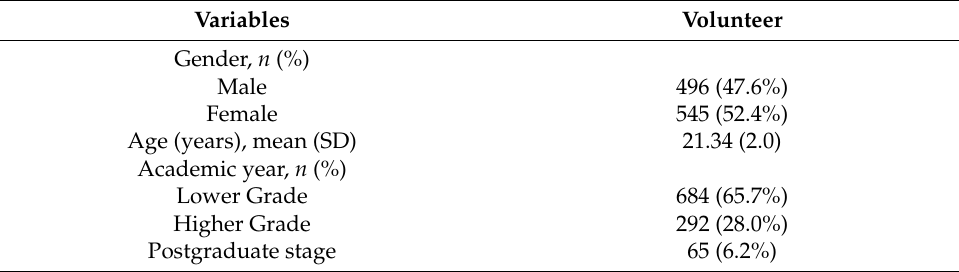
Table 1. Baseline characteristics of participants ( n =